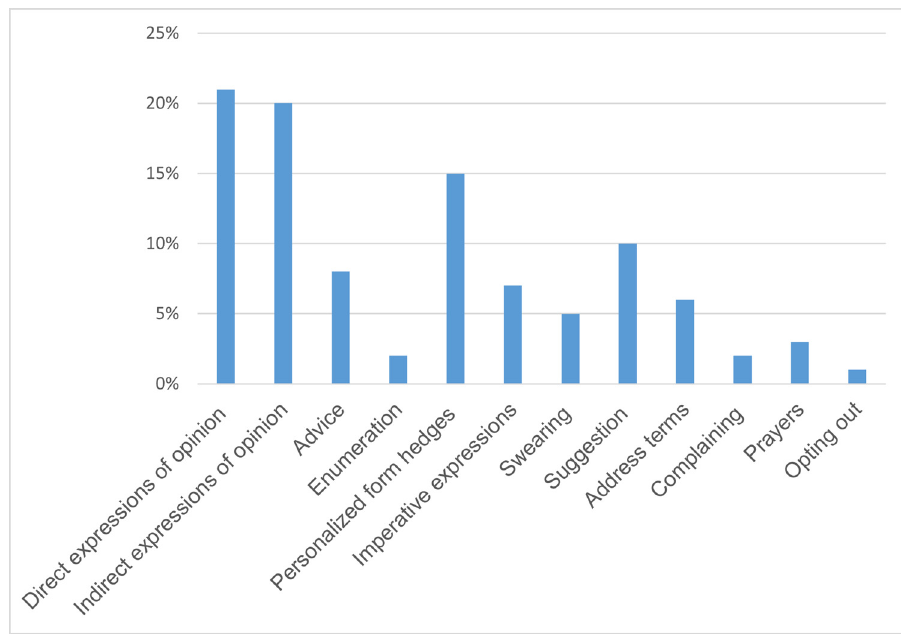
Figure 1: Opinion - expressing strategies used by JA